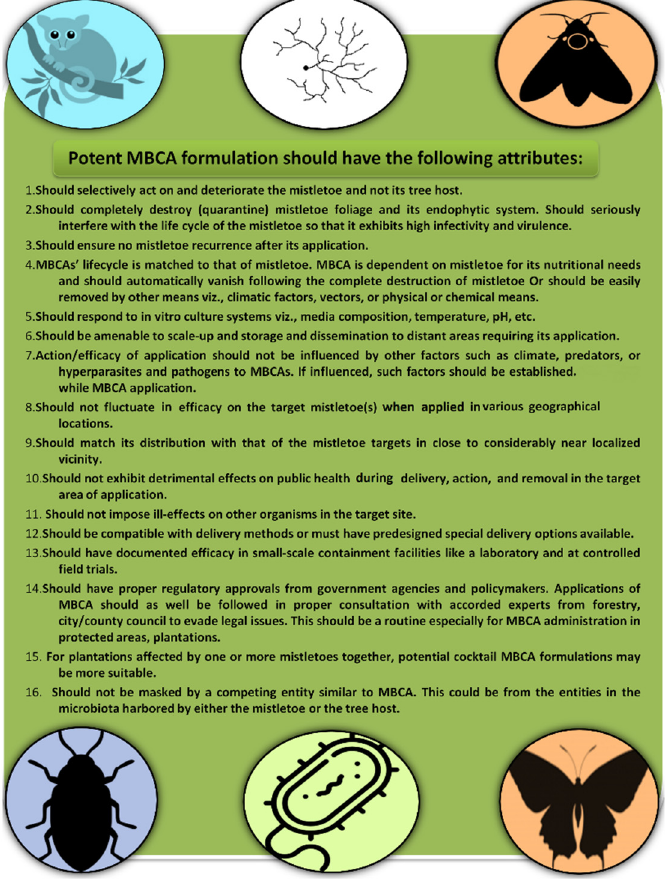
Figure 3. Selective traits for testing and screening of potential MBCAs. The infographic depicts